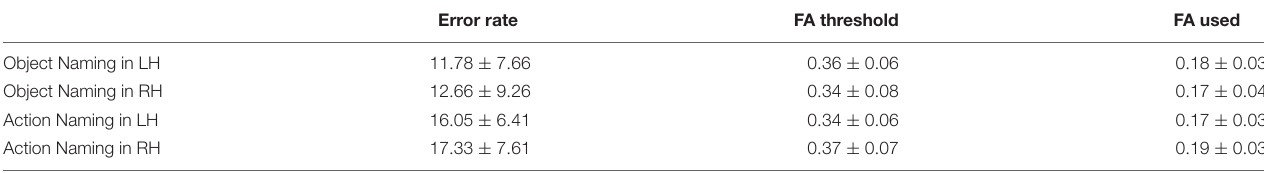
TABLE 1 | Mapping and tracking parameters per task and hemisphere in mean ± standard deviation.